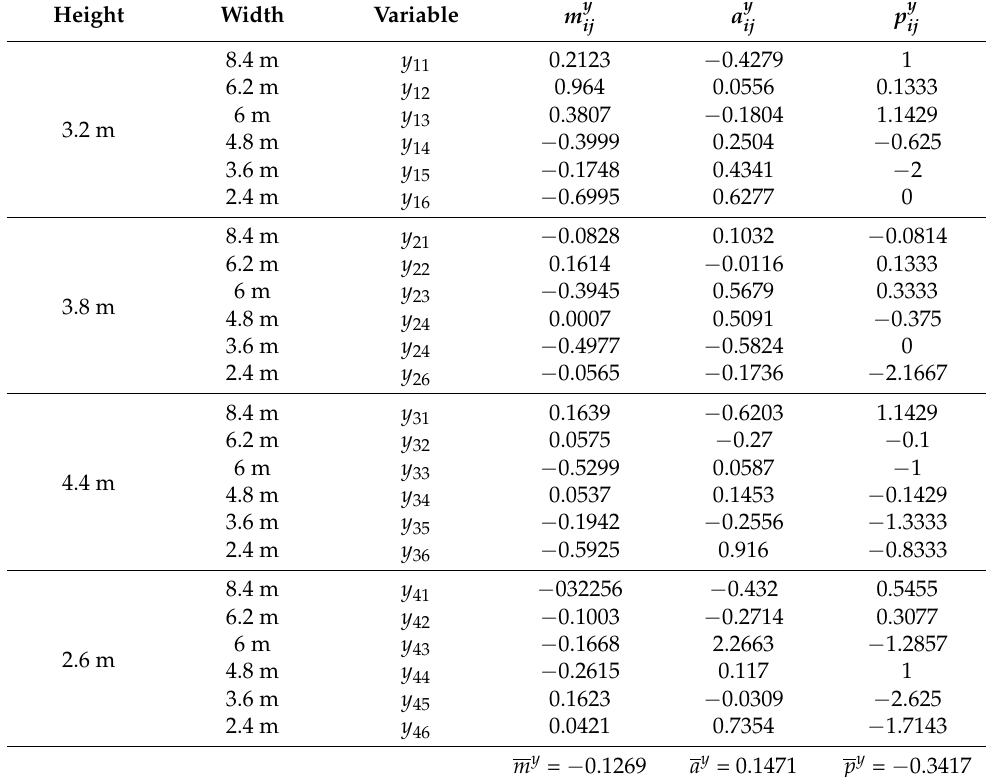
Table 3. Grouping of variables for each parameter of the classroom characteristic